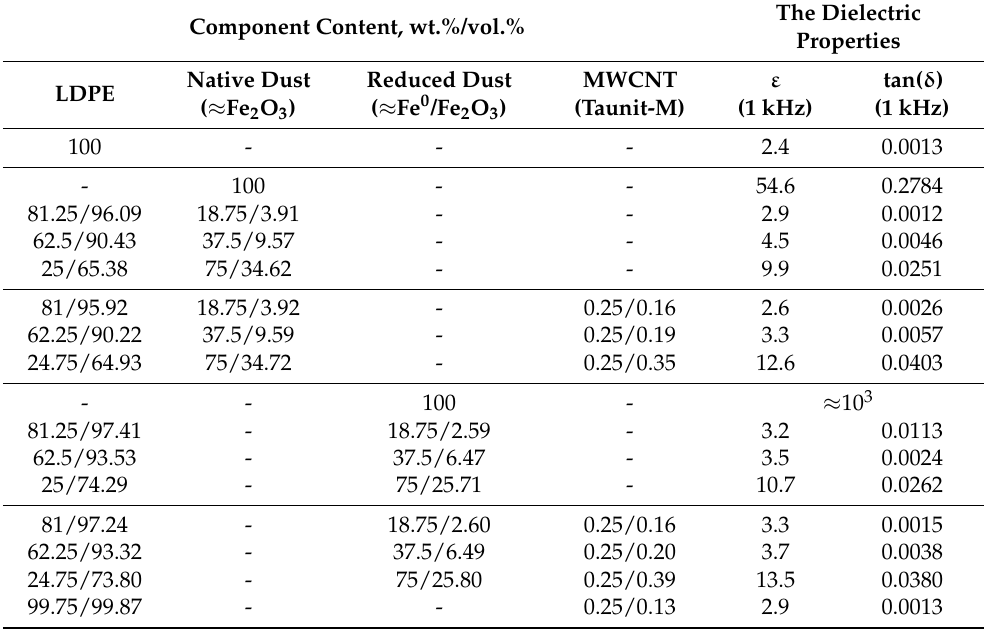
Table 2. The dielectric properties of the composites at 1 kHz.